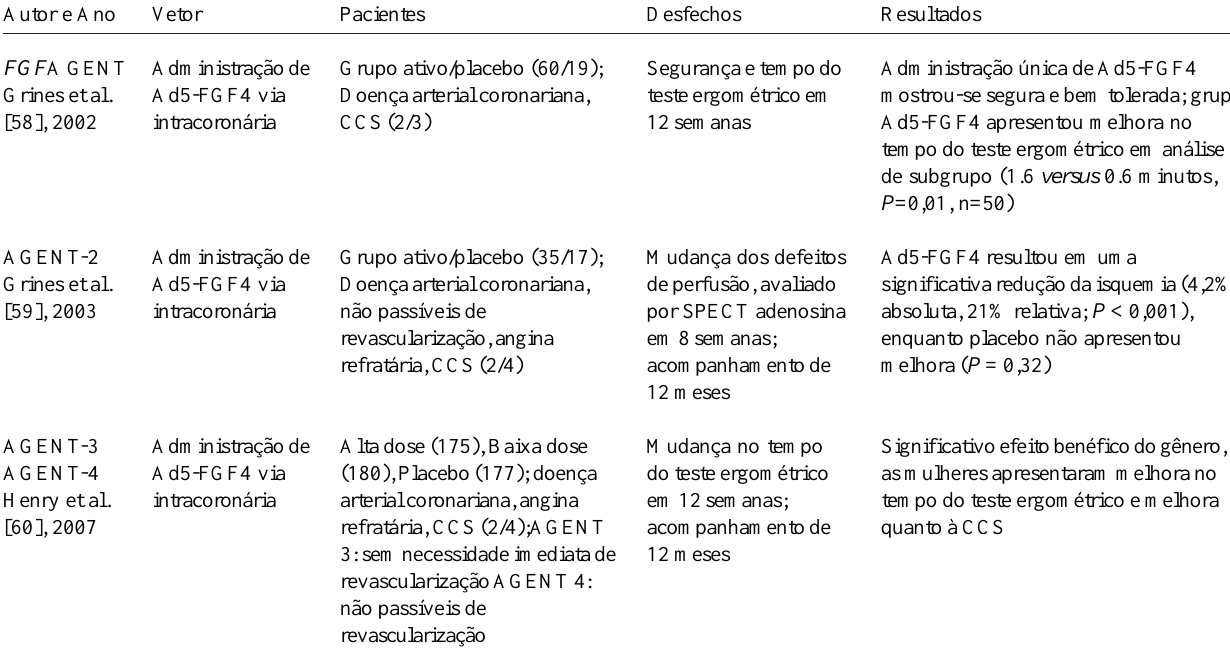
Tabela 3. Ensaios Clínicos envolvendo Terapia Gênica com FGF. Autor e Ano FGF A GENT Grines et